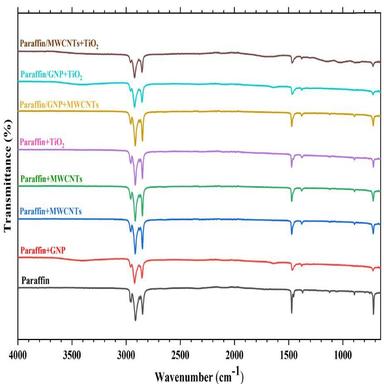
FT-IR spectra of thermally treated samples.